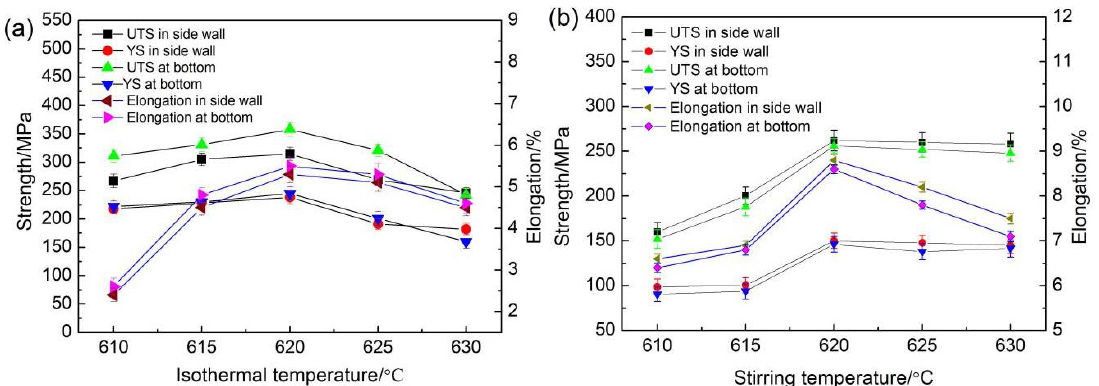
Figure 7. Influence of different stirring temperature on mechanical properties of rheoformed composite components reinforced by 5 vol % Al 2 O 3 nanoparticles for 25 min stirring time and matrix components ( a ) composite components; ( b ) matrix components.